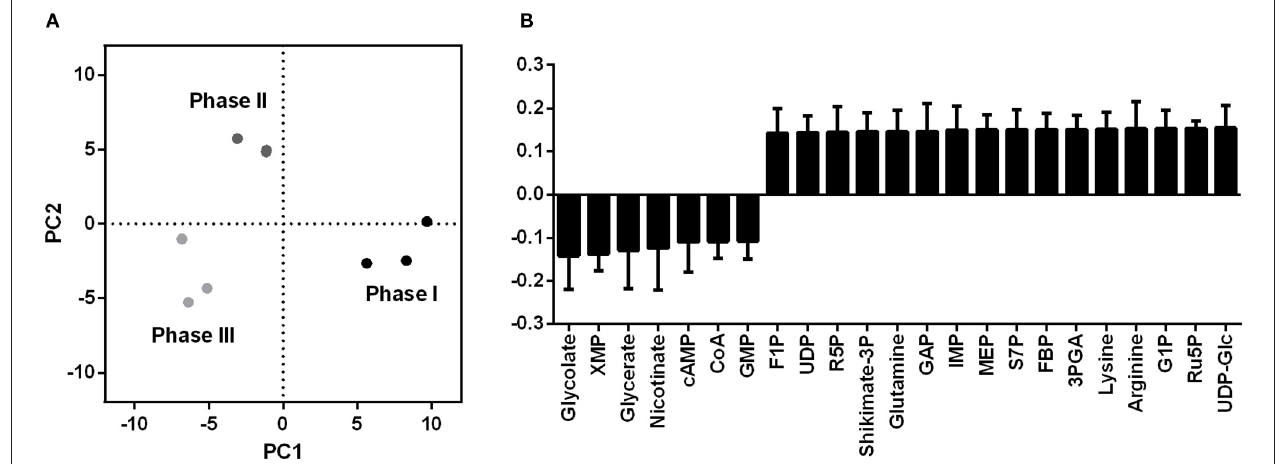
FIGURE 5 | Principal component analysis (PCA) for different growth phases of B. subtilis WB PX43- pgs on xylose. The score plot (A) demonstrates the separation according to principal component 1 (PC1) and PC2 for triplicate samples obtained from three cultivation time points corresponding to the phases indicated in Figure 4 . Samples were taken after 9, 11, and 14h for phase I, II, and III, respectively. The loading data for metabolites exhibiting the highest values for PC1, thus changing throughout the growth phases, are shown in (B) . 3PGA, 3-phosphoglycerate; AMP, adenosine 5 ′ -monophosphate; cAMP, 3 ′ ,5 ′ -cyclic AMP; CoA, coenzyme A; F1P, fructose-1-phosphate; FBP, fructose-bisphosphate; G1P, glucose-1-phosphate; GAP, D -glyceraldehyde 3-phosphate; GMP, guanosine 5 ′ -monophosphate; IMP, inosine 5 ′ -monophosphate; MEP, methyerythritol 4-phosphate; R5P, ribose-5-phosphate; Ru5P, ribulose-5-phosphate; S7P, sedoheptulose-7-phosphate;